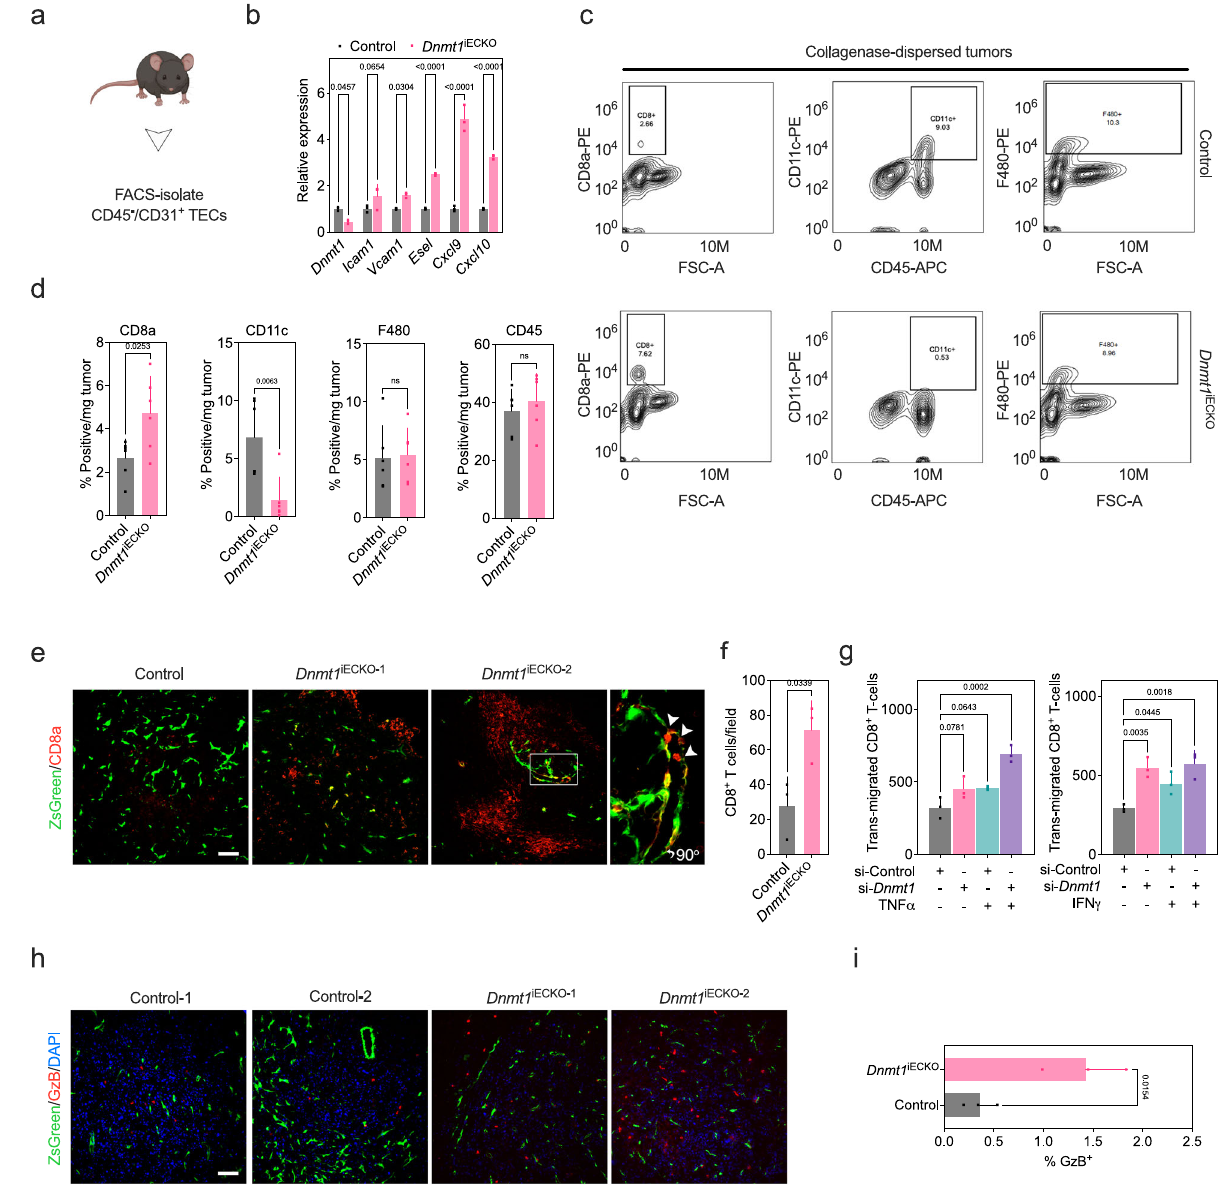
Fig.3|Conditionaldeletionof Dnmt1 inECsreprogramsthetumorvasculature resulting in increased numbers of intra-tumoral and perivascular CD8 + T-cells and increased GzB + cells. a Orthotopically injected EO771 mammary tumors were dissociatedwithanenzymecocktail.CD45 − /CD31 + TECswereisolatedandanalyzed using FACS ( n = 3 pooled tumors from the indicated group of mice). b qPCR ana- lysisofselectedtargetgenesinTECsassayedintriplicate.Datawereanalyzedusing ANOVA followed by Sidak ’ s multiple comparisons test. c Same as in “ a ” except the indicated antibody combinations were used to identify immune cell subsets (representative contour plots are shown) in collagenase-dispersed tumors. d Quanti fi cation of FACS analysis shown in “ c ” ( n = 6 mice/group) and each data point is an individual mouse. Data were analyzed using Student ’ s t test. e Cryosections of EO771 mammary tumors from control versus Dnmt1 iECKO mice stained with anti-CD8 antibodies (red fl uorescence). Vessels are marked with ZsGreen. The images show representative fi elds of view of “ small ” ( Dnmt1 iECKO -1)